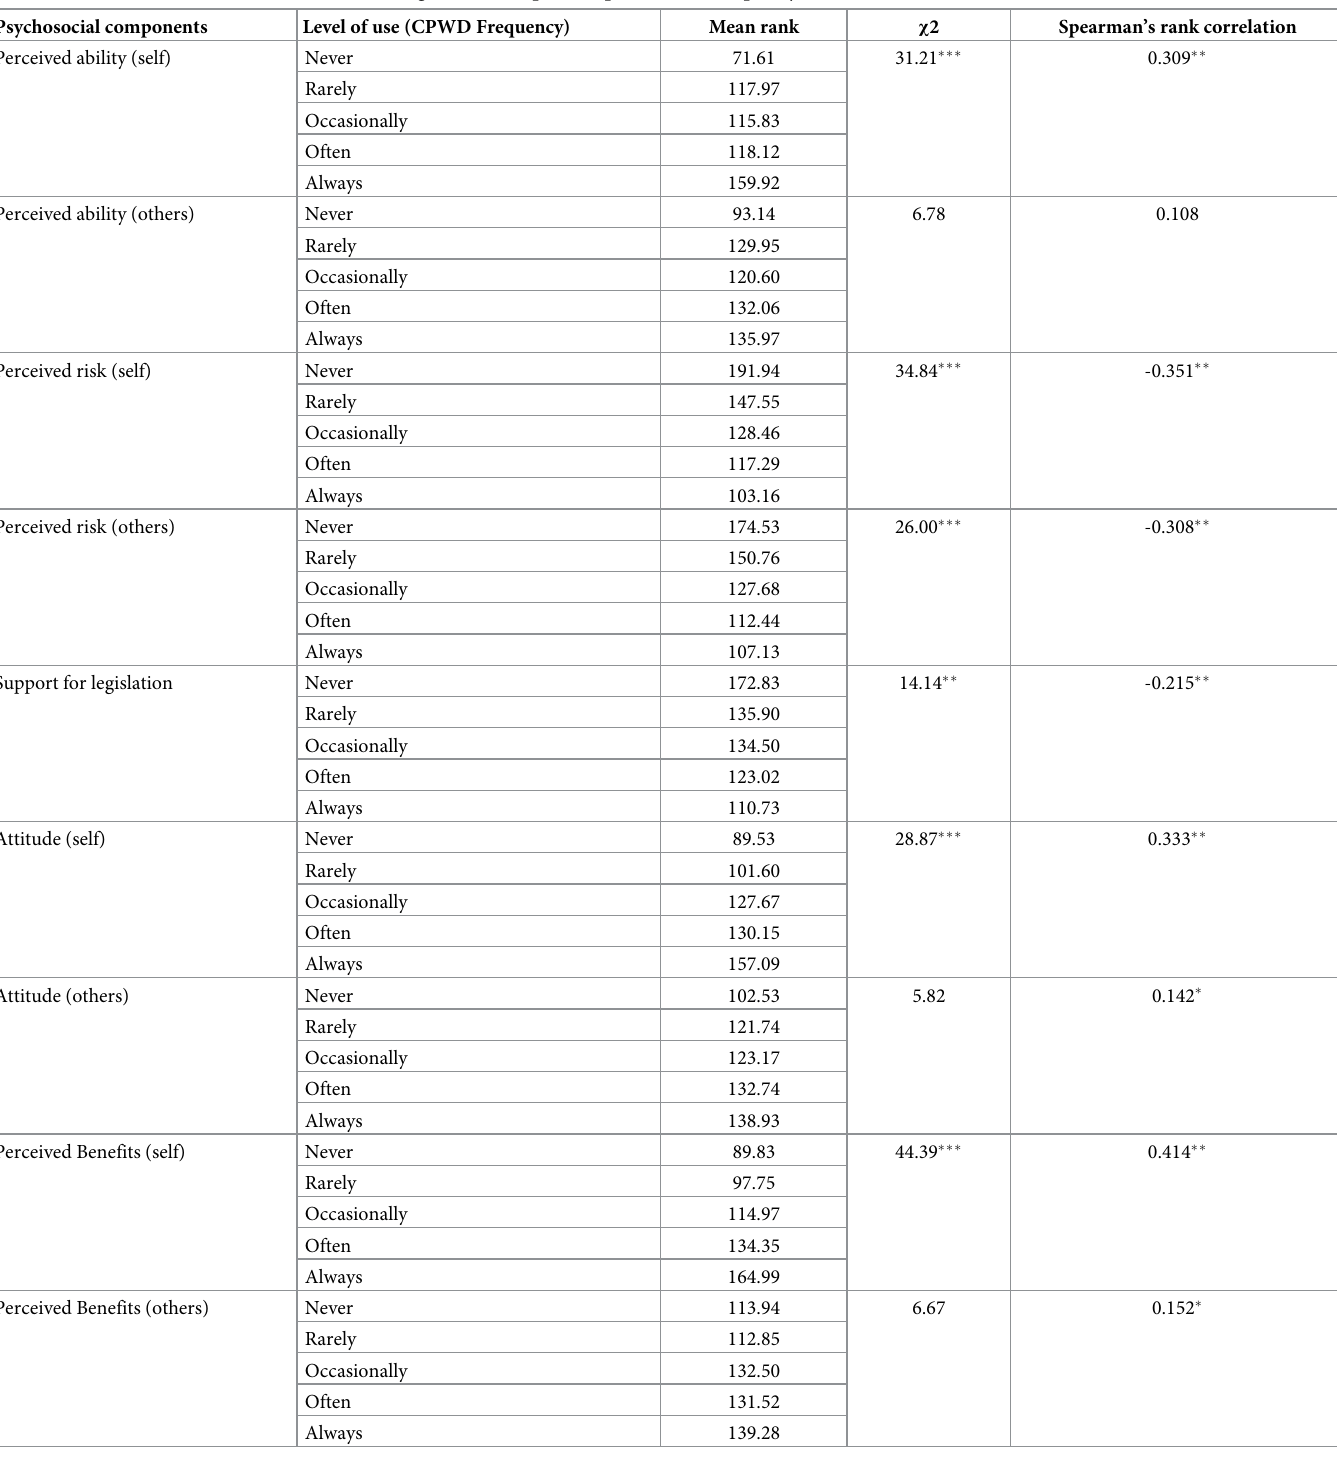
Table 4. Kruskal–Wallis and correlation tests for significant independent predictors of frequency of